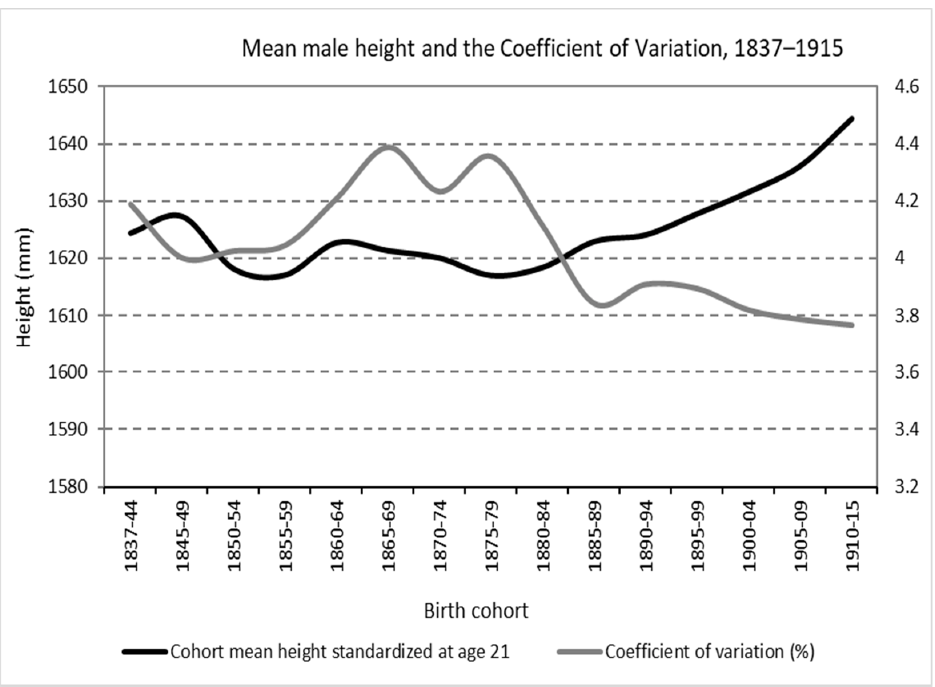
Figure 3. Mean male height at age 21 and coefficient of variation in central Spain, birth cohorts 1837–1915 (Source: calculated with data from the Expedientes .).